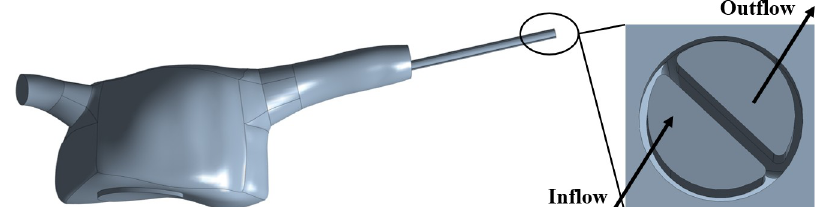
Fig 4. RA computational domain with example catheter